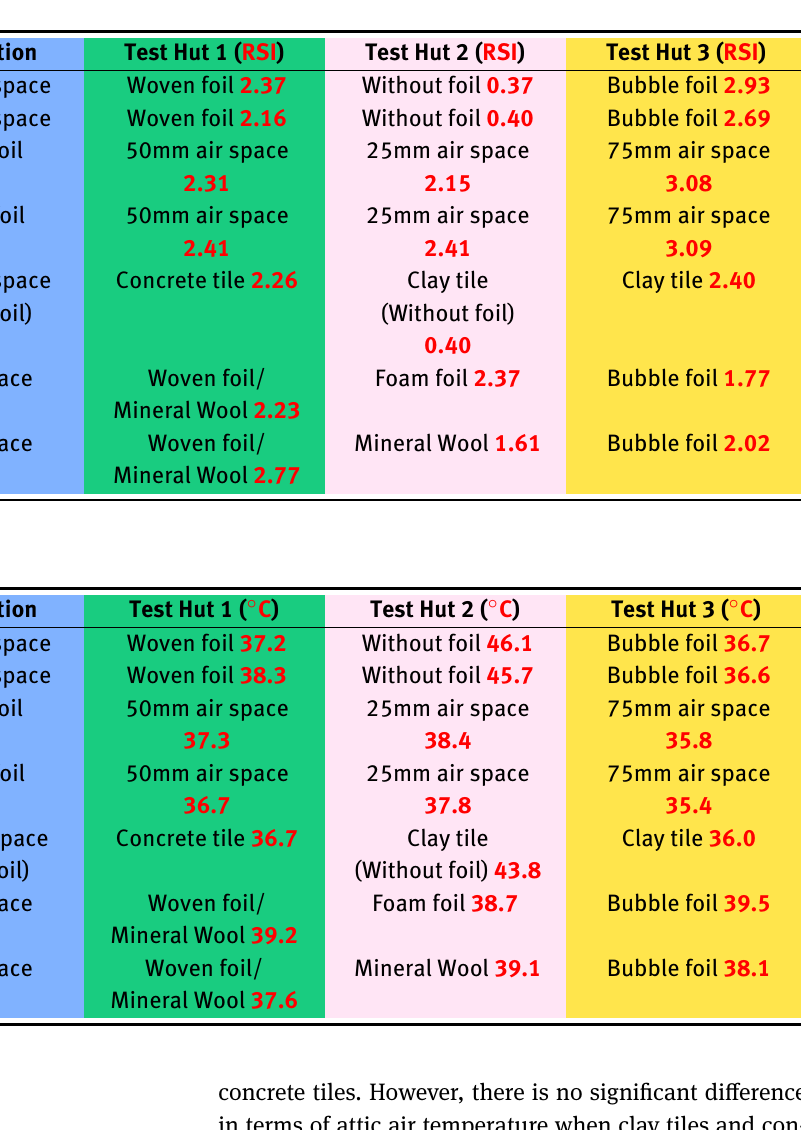
Table 2: RSI for the test huts